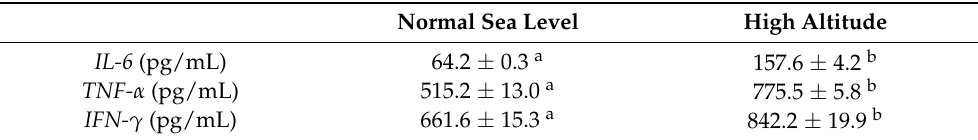
Table 4. Alterations in serum IL-6, TNF- α , and IFN γ concentrations in groups living at normal sea level and at high altitude.